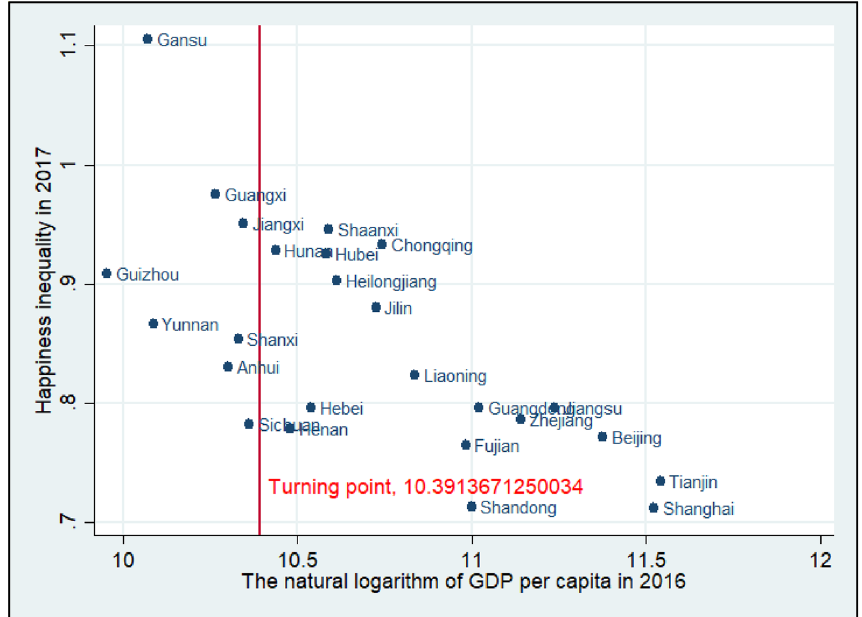
Figure 2. The turning point of the subjective wellbeing Kuznets curve, full sample 41,42